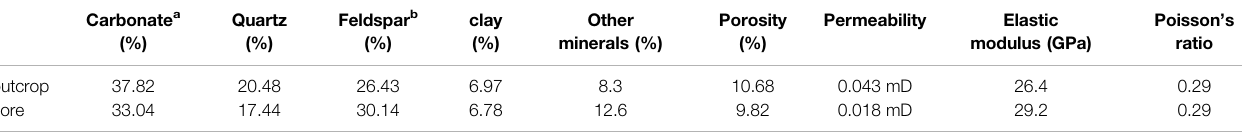
TABLE 1 | Property comparison of cores and